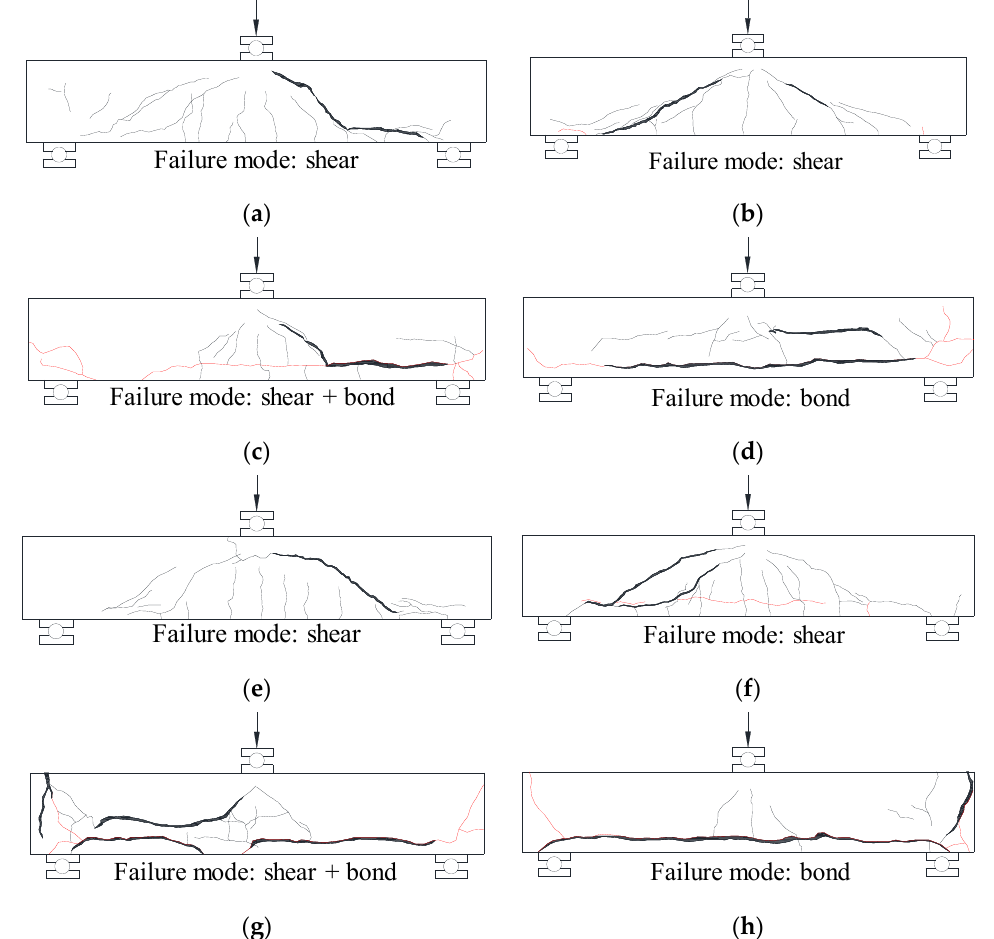
Figure 6. Crack patterns of test specimens after failure. ( a ) TS-0 specimen; ( b ) TS-3 specimen; ( c ) TS-8 specimen; ( d ) TS-15 specimen; ( e ) TH-0 specimen; ( f ) TH-3 specimen; ( g ) TH-8 specimen; ( h ) TH-15 specimen.